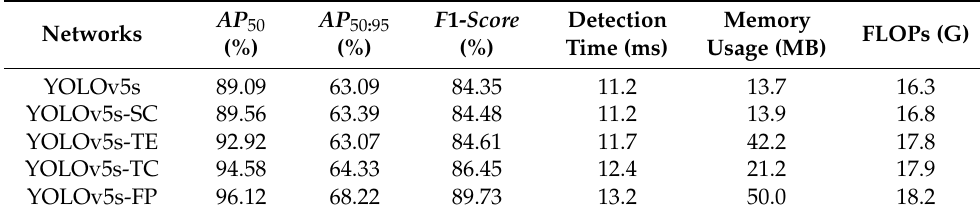
Table 4. Ablation experiments of the